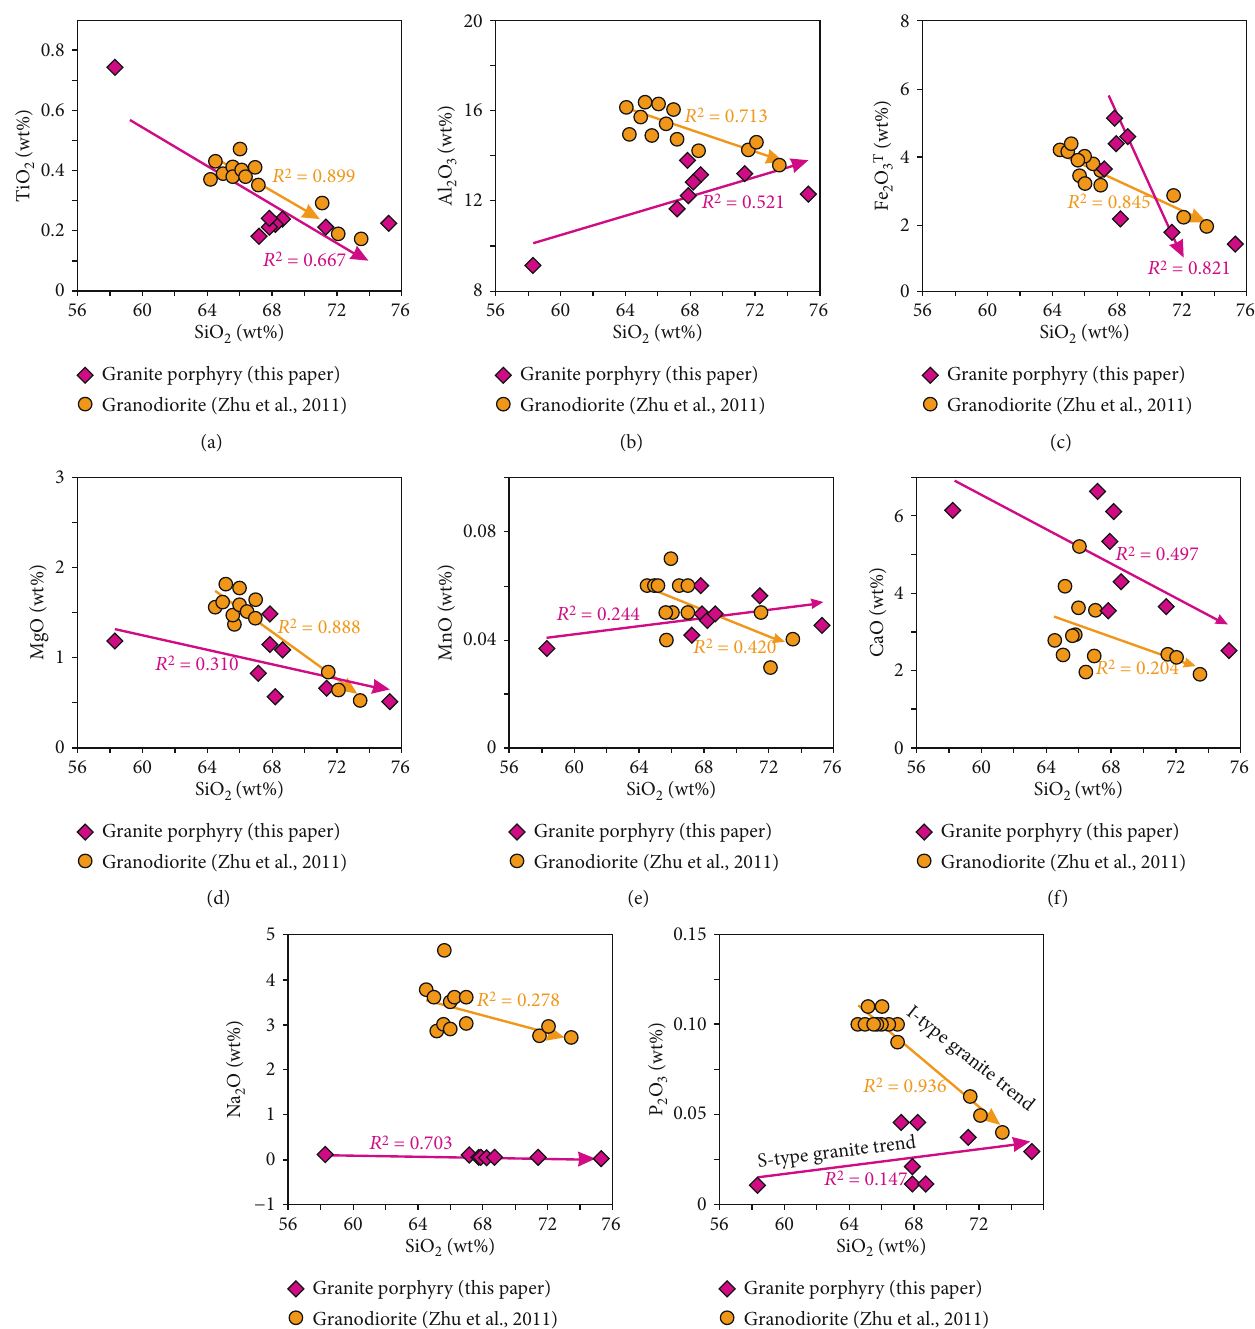
Figure 11: Variation of major elements with SiO after Li et al., 2007